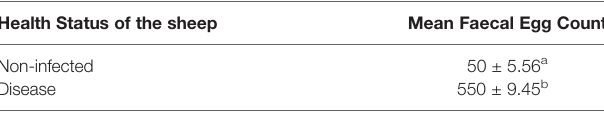
TABLE 3 | Mean FEC of the Non-infected and Infected sheep with Haemoncus contortus